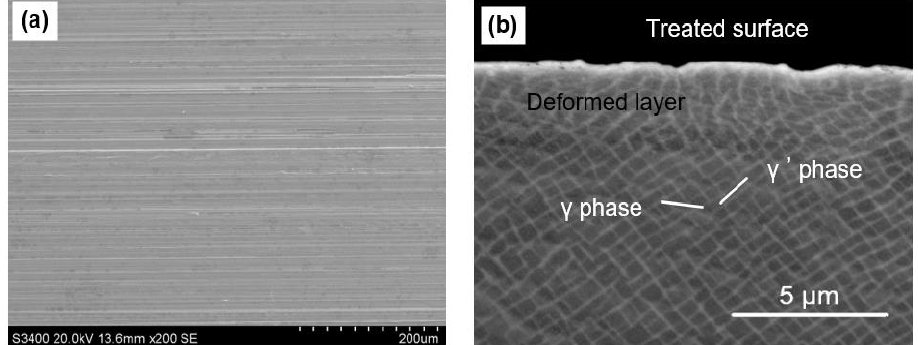
Figure 2. ( a ) Treated surface and ( b ) cross-sectional microstructure of SMCGT sample